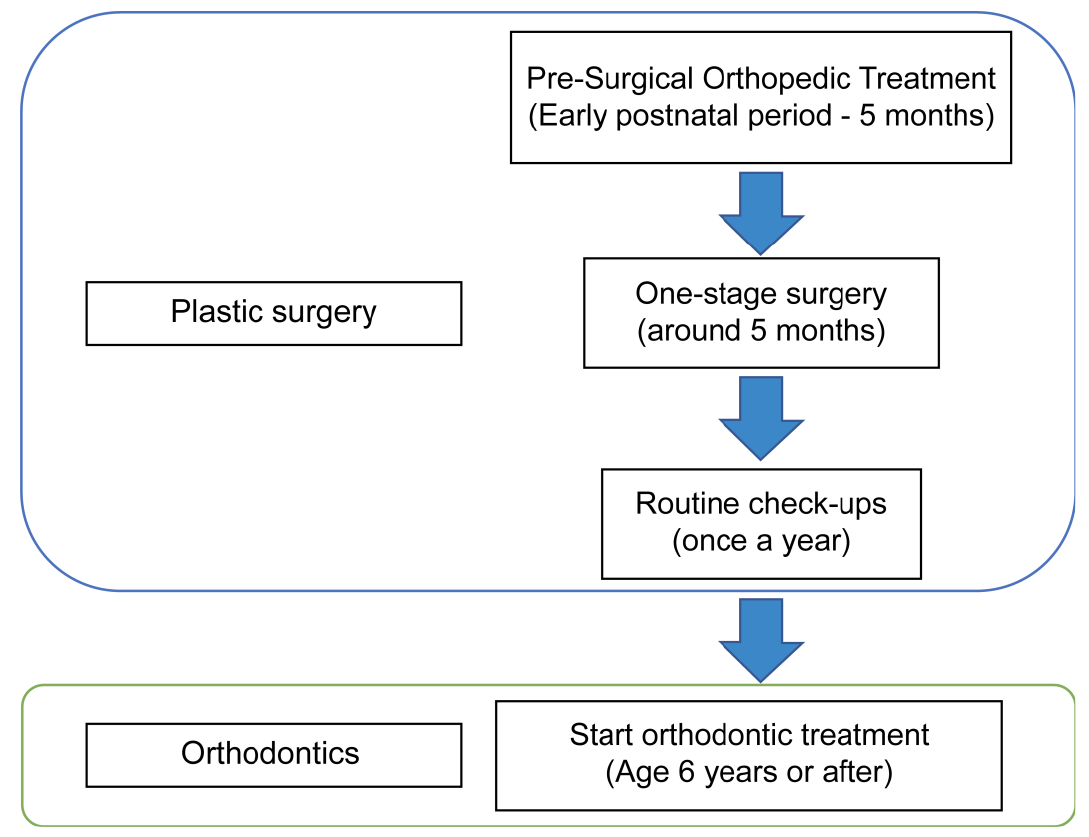
Figure 5. Flow of one-stage surgery.